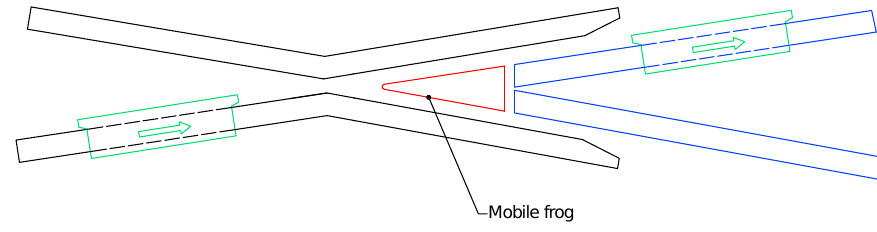
Figure 4. Crossing with proposed mobile frog.